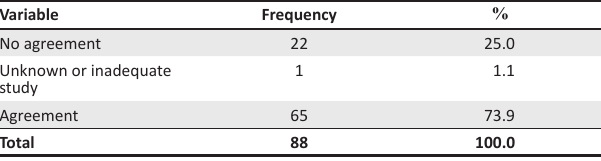
TABLE 1 : Frequency and percentage agreement between ultrasound and magnetic resonance imaging.